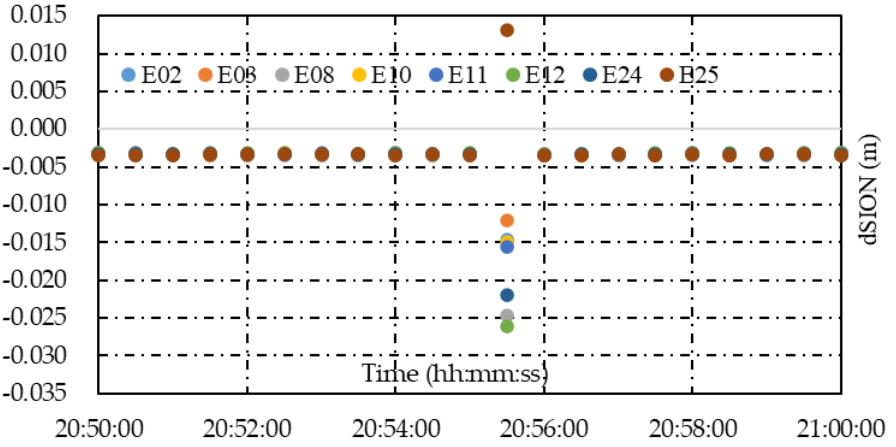
Figure 13. dSION between method B and A from kinematic PPP with various satellites.